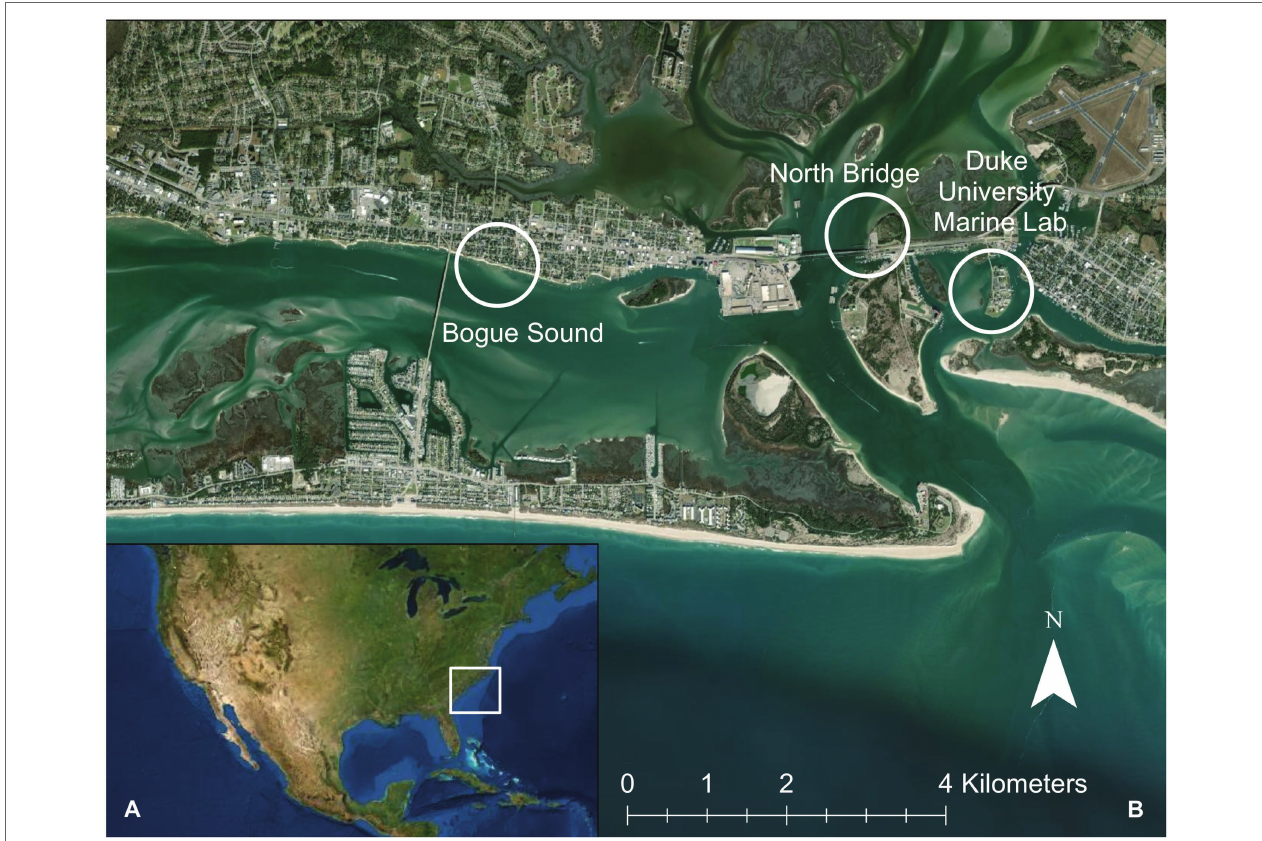
FIGURE 1 | (A) Location of study site in Beaufort, NC, United States. (B) Distribution of three sample collection sites with inset of Newport River Estuary, Bogue Sound, and Beaufort Inlet. White circles indicate each of the three sites (Duke University Marine Lab, Bogue Sound, and North